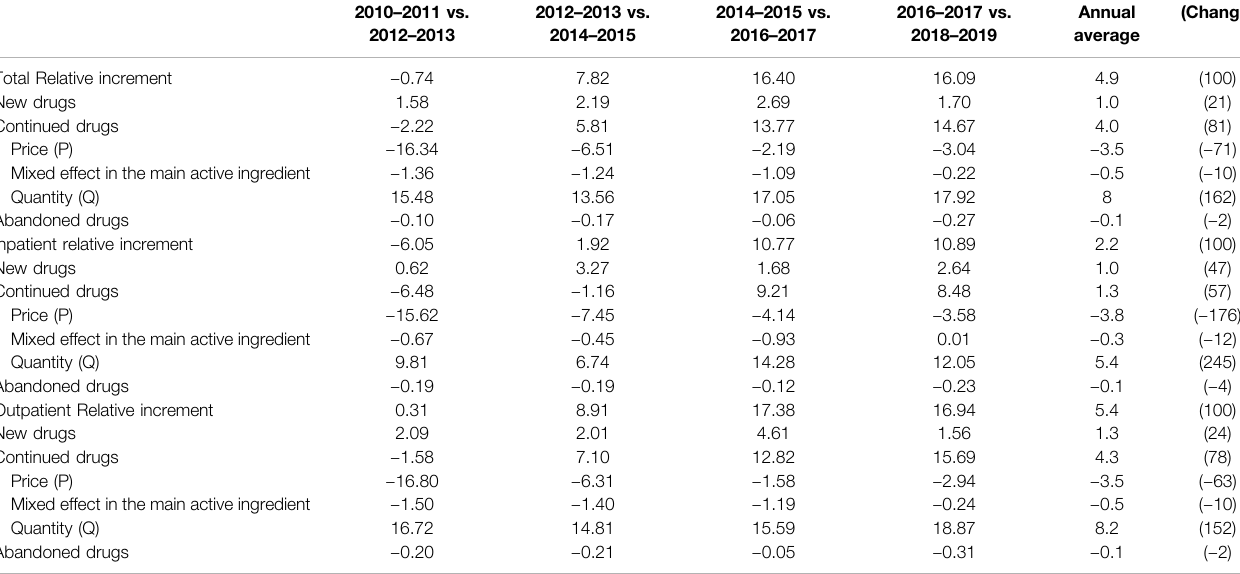
TABLE 2 | Contributions to changes in pharmaceutical spending by 2-year periods, overall and by sector (%).